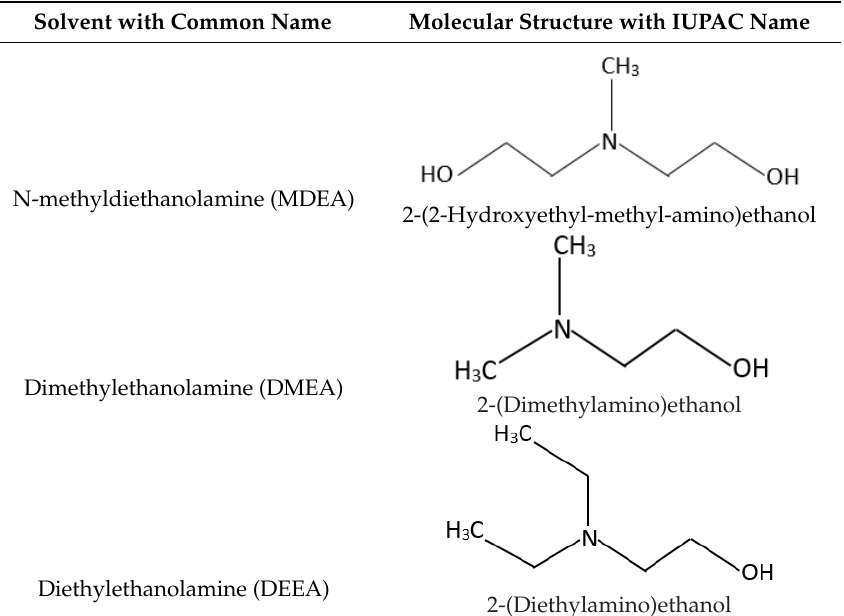
Table 1. Molecular structures and IUPAC names of N-methyldiethanolamine (MDEA),